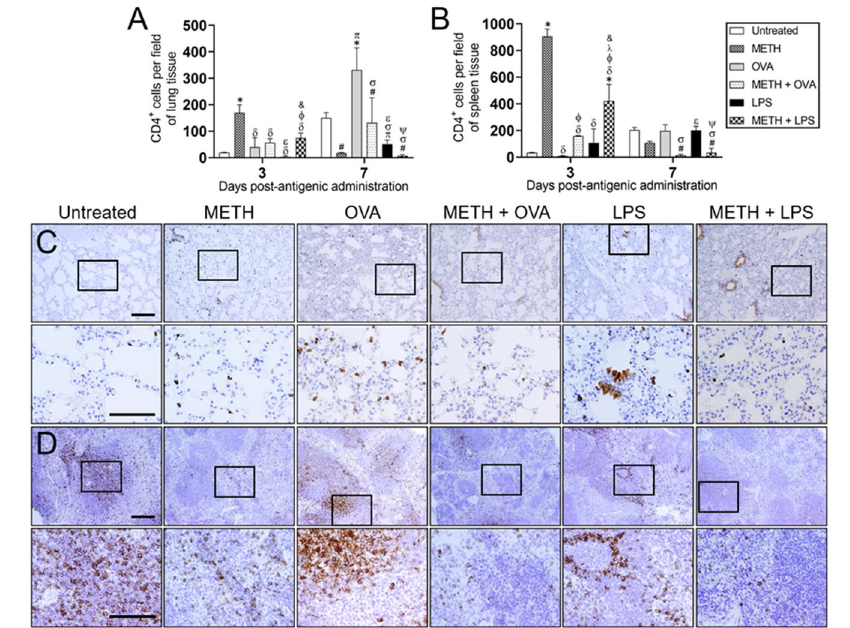
Figure 3. METH inhibits CD4 + cell recruitment into the lung and splenic tissue of C57BL/6 mice after OVA or LPS challenge. Counts of helper T (CD4 + ) cells per 0.1 g of (A) lung and (B) splenic tissue of C57BL/6 mice ( n = 5 mice per condition per day) 3- and 7-days post-METH and OVA/LPS administration were analyzed by microscopic counts. Bars indicate the average number of CD4 + cells ( n = 5 mice per condition per day) for untreated (PBS), METH, OVA, METH + OVA, LPS, and METH + LPS and error bars indicate STDEV. Symbols (*, π, , λ, #, σ, and ψ) indicate P value significance ( P < 0.05) calculated using ANOVA and adjusted by use of the Tukey’s post-hoc analysis. *, π, , and λ indicate significantly higher CD4 + cell infiltration than in the ϕ untreated, METH, OVA, and METH + OVA-treated groups, respectively. #, σ, and ψ indicate significantly ϕ lower CD4 + cell infiltration than in the untreated, OVA, and LPS-treated groups, respectively. Representative CD4 stained tissue sections of (C) lungs and (D) spleens excised from untreated, METH, OVA, METH + OVA, LPS, and METH + LPS-treated animals after 7 days post-Ag challenge are shown (scale bars for 10 and 60 × magnification, 100 μm). Brown staining indicates CD4 + cellular